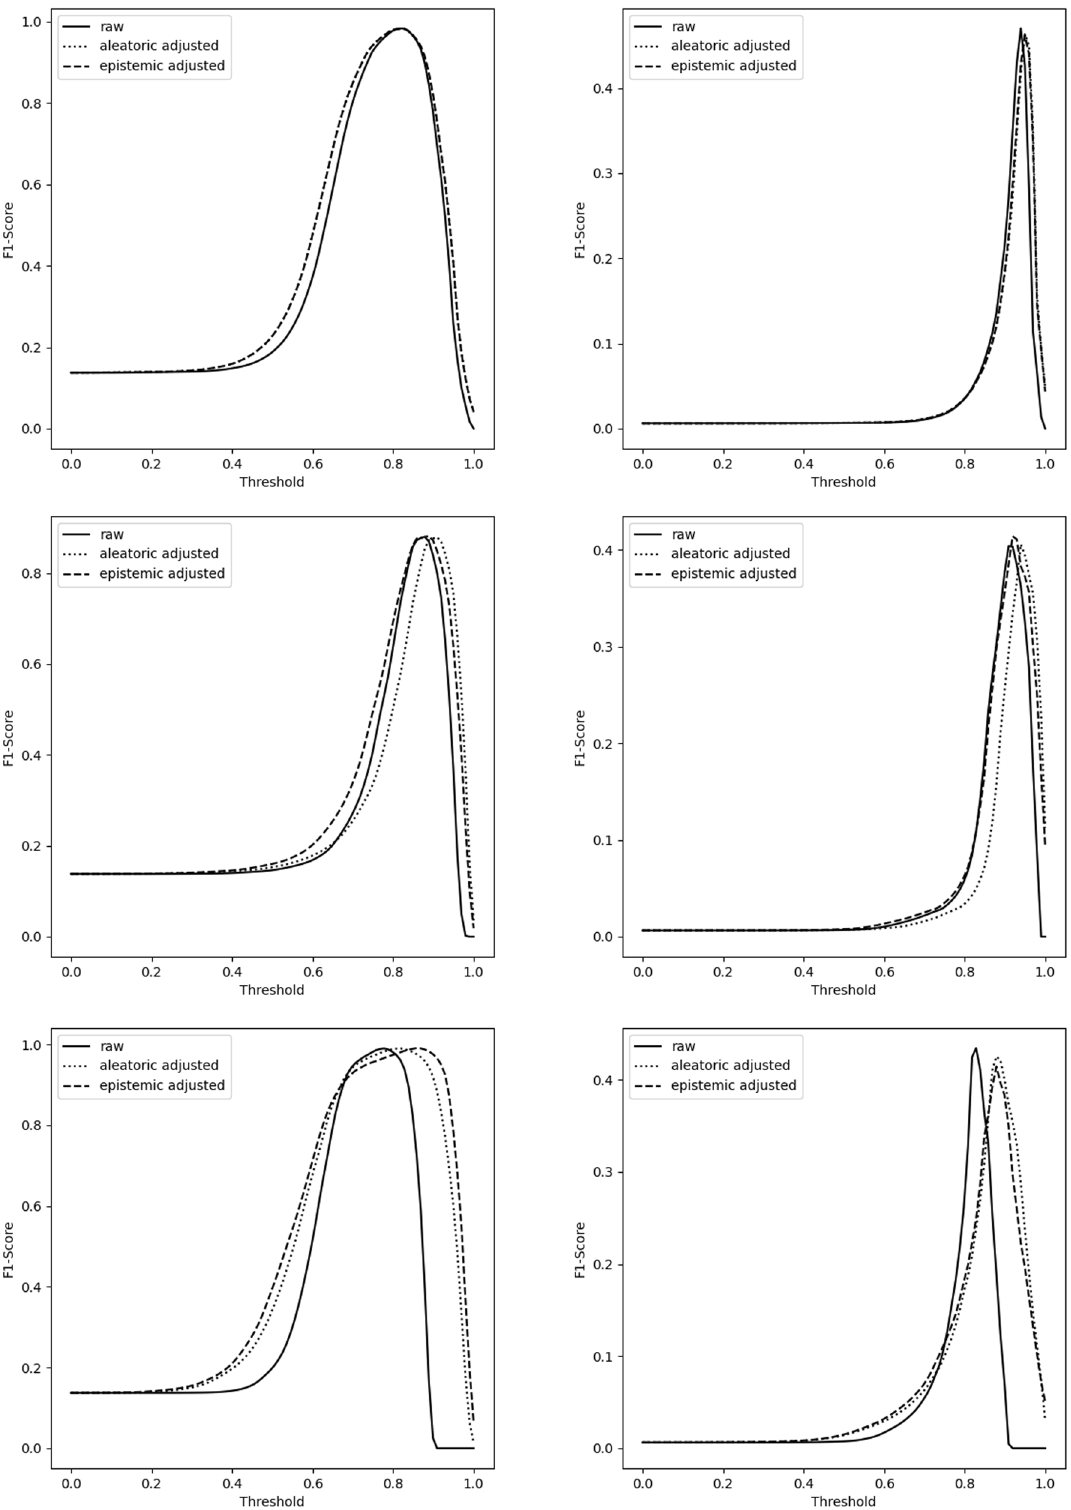
Fig. 15 F1-Score vs. Threshold curves for Fig. 5e (left column) and Fig. 5h (right column). Top row: variational model; middle row: Monte- Carlo dropout model; bottom row: ensemble model. the novel dataset (Fig. 14) when compared to the training dataset threshold and effects the maximum F1-Score, positively for the Monte-Carlo dropout and ensemble models but negatively for the (Fig. 13). When tested on the images from within the training distribution variational model (Fig. 13). When challenged with novel images adjusting for the epistemic uncertainty shifts the optimal from outside the training distribution a similar effect is seen, Published in partnership with CSCP and USTB npj Materials Degradation (2022)